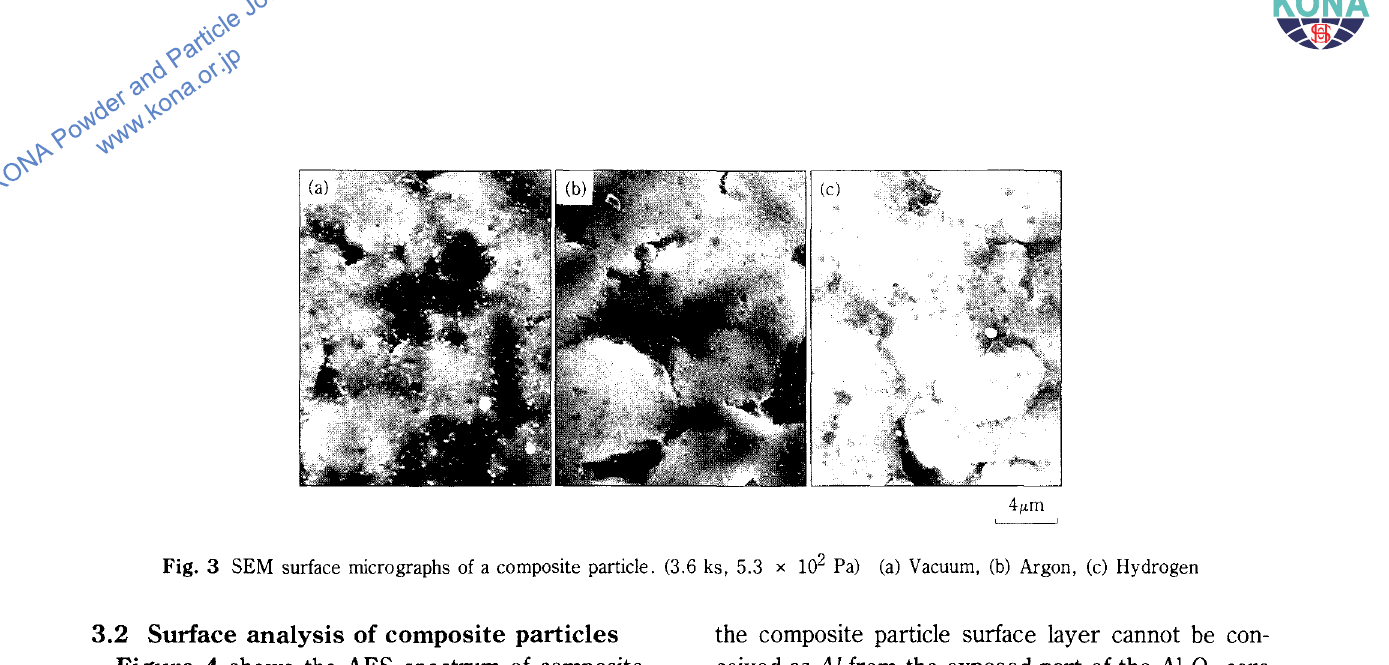
Fig. 3 SEM surface micrographs of a composite particle. (3.6 ks, 5.3 x 102 Pa) (a) Vacuum, (b) Argon, (c) Hydrogen